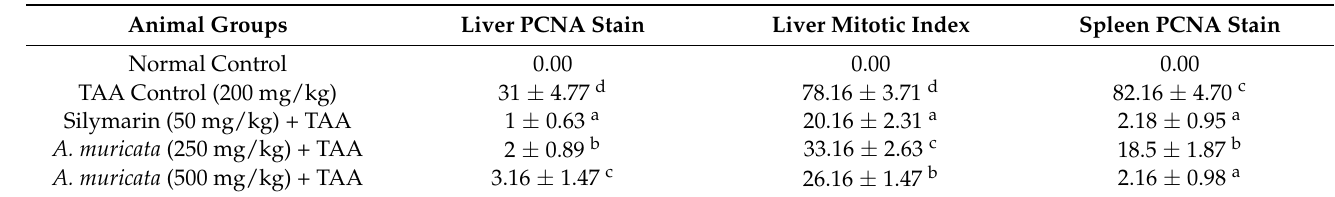
Table 3. Effect of A. muricata on the PCNA staining of liver and spleen sections and the mitotic index of the liver.